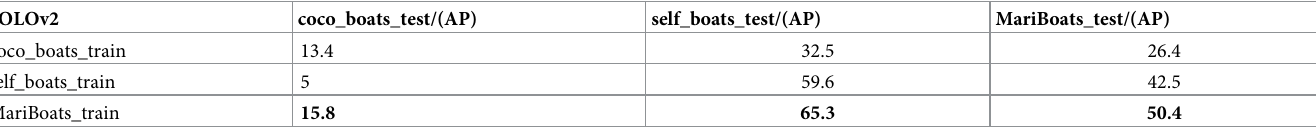
Table 4. Test results of SOLOv2 in the three instance segmentation datasets.